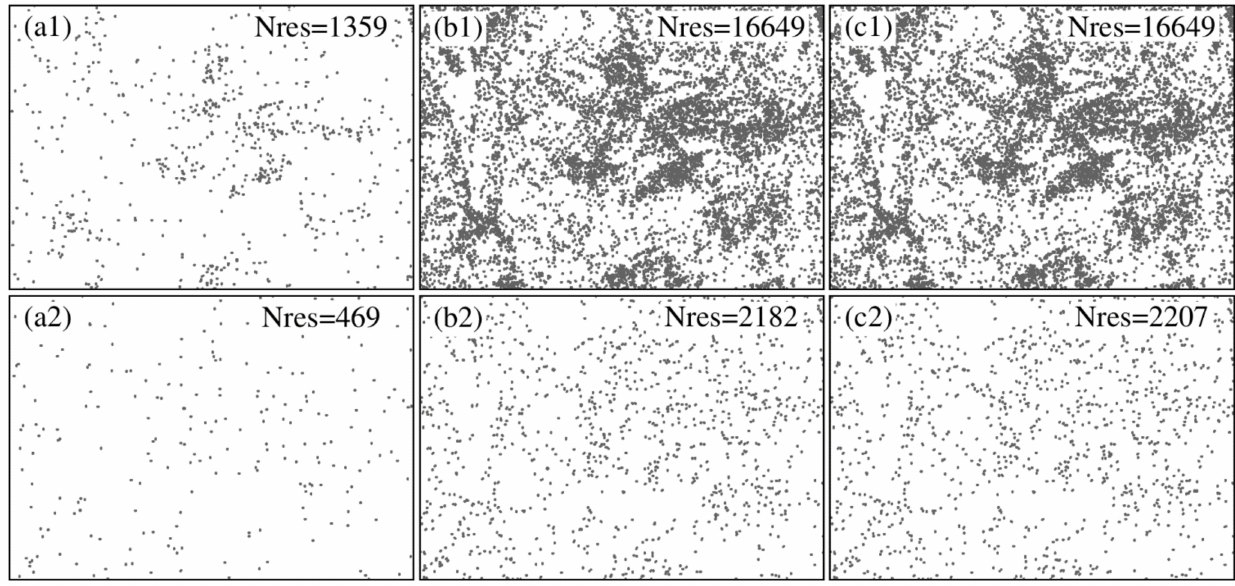
Figure 9. The distribution of the residues of different unwrapping methods, where the grey dots indicate the residues and Nres indicates the number of